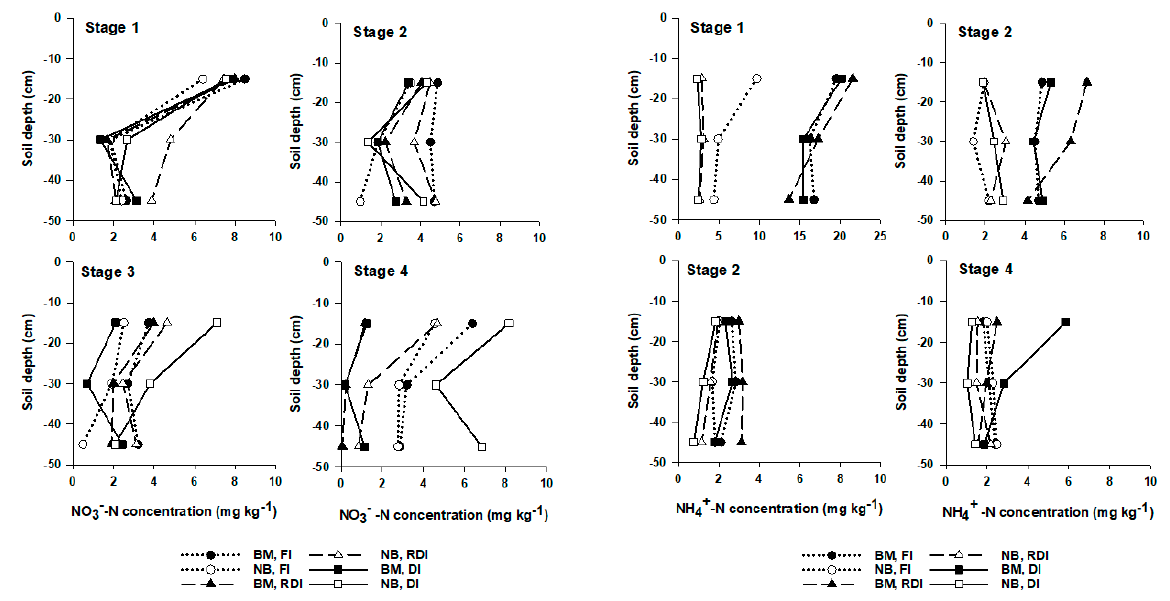
Figure 4. Soil NO 3 − -N and NH 4+ -N distributions as affected by N application timing [(25% pre-plant with 75% fertigation (BM), and zero pre-plant with 100% fertigation (NB)] under full irrigation (FI, 100% ETc), deficit irrigation (DI, 66% ETc) and regulated deficit irrigation (RDI, 66% 0–4 weeks after transplanting and 100% ETc from week 5) during spring 2018 season in Immokalee Florida.